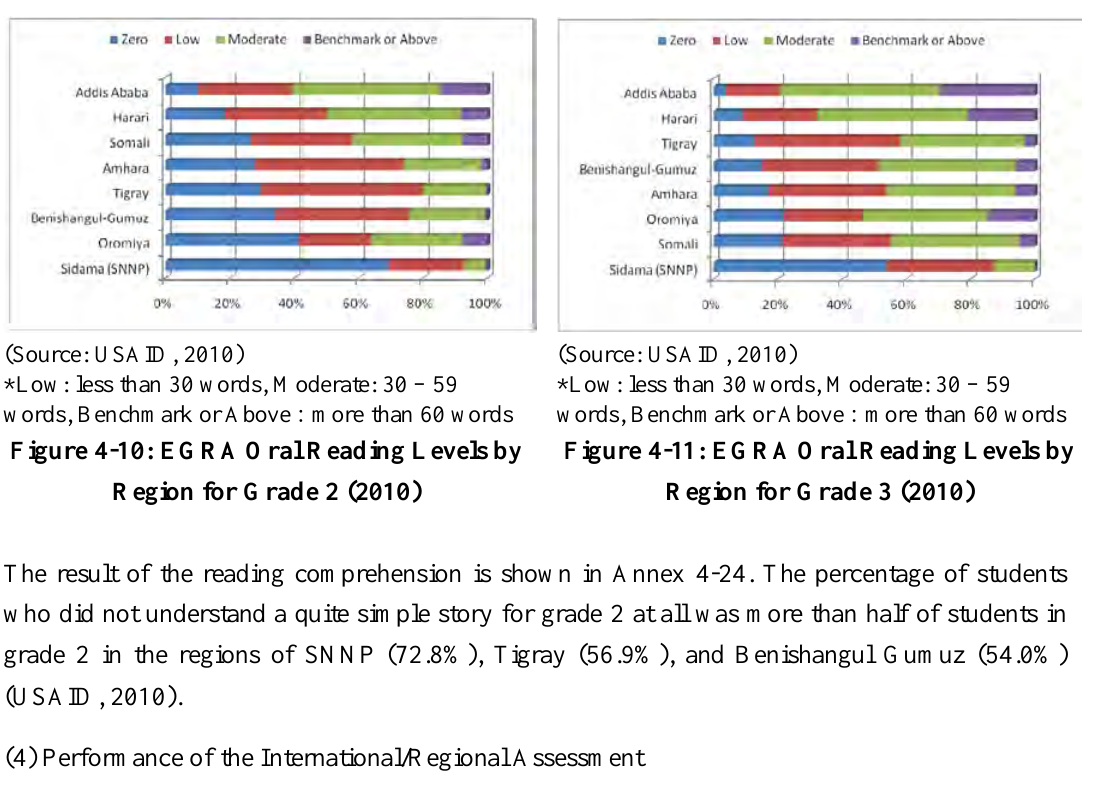
words, Benchmark or Above ： more than 60 words Figure 4-11: EGRA Oral Reading Levels by Region for Grade 3